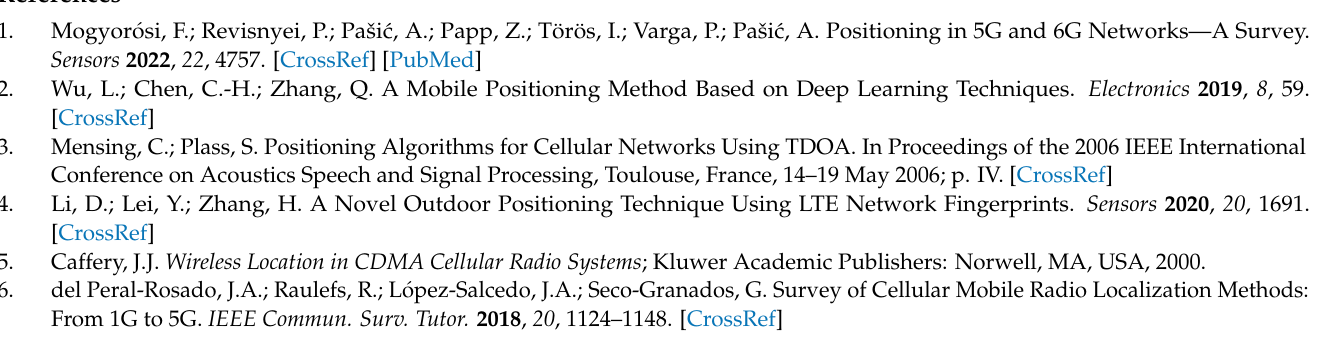
Figure 18. Two-base station system measurement result.